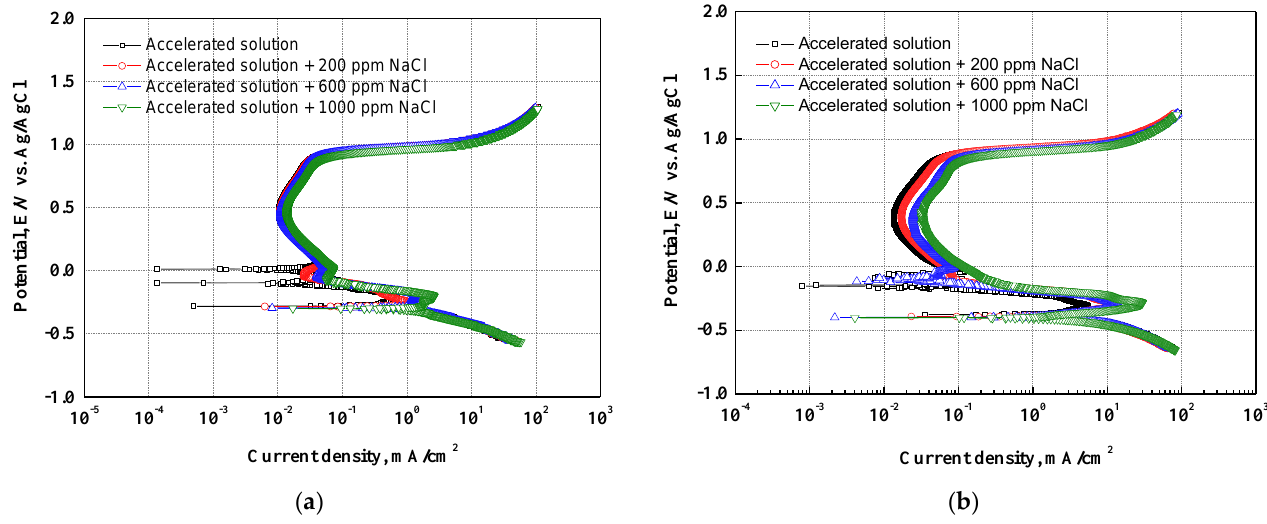
Figure 2. Potentiodynamic polarization curves after a potentiodynamic polarization experiments: ( a ) 304 stainless steel; ( b ) 316L stainless steel.